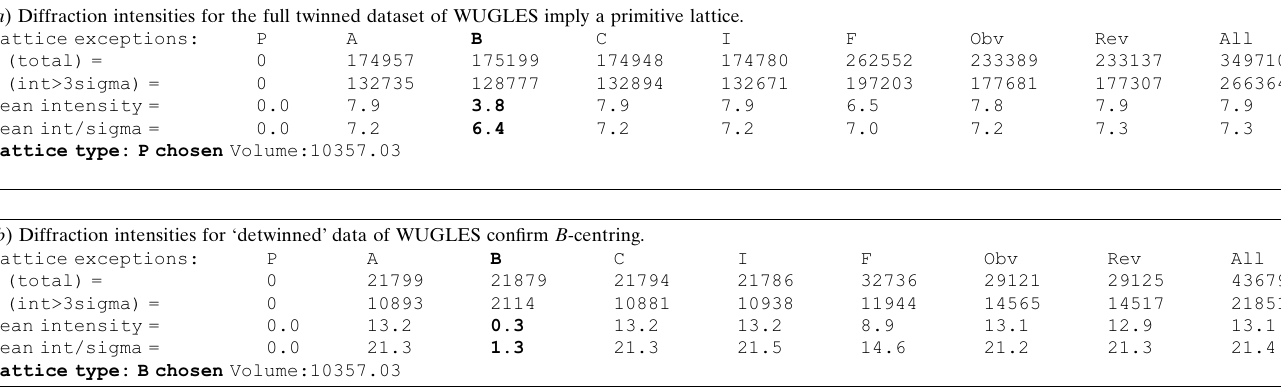
Table 3 Annotated excerpts from XPREP log files for WUGLES. ( a ) The full dataset of the twin is consistent with a primitive unit cell, though there is a weak suggestion of B-centring. ( b ) The ‘detwinned’ diffraction data for WUGLES clearly indicate that the pseudo-hexagonal unit cell of the individual, is B - centred, not